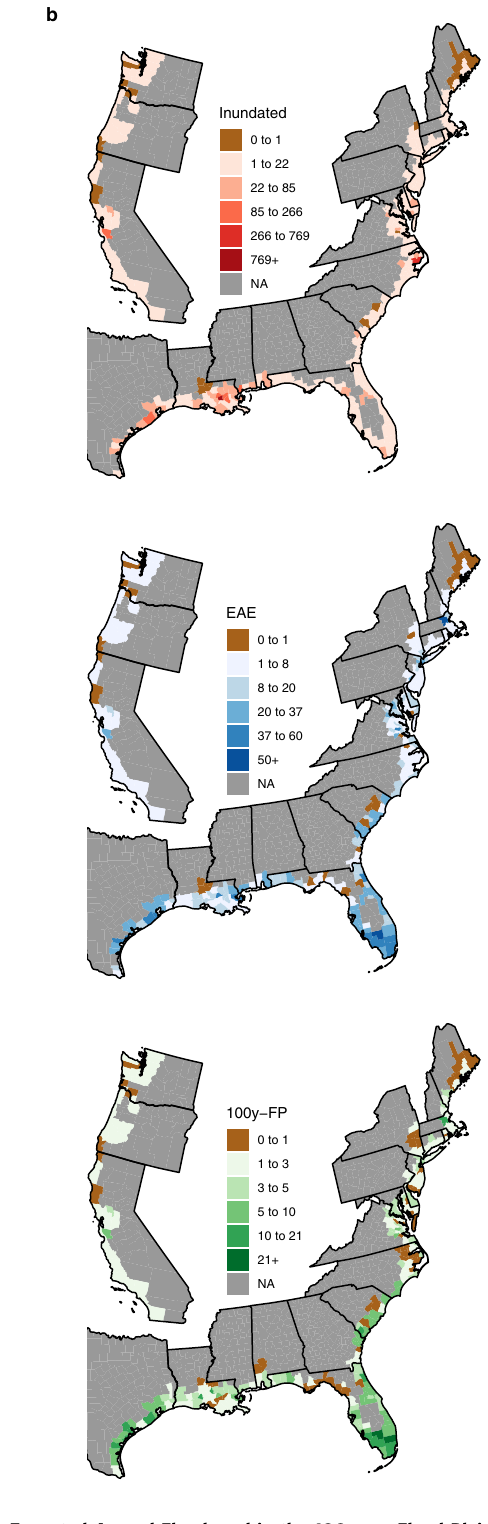
Fig. 2 Projected populations Inundated under the Mean Higher High Water, Expected Annual Flood, and in the 100-year Flood Plain under Shared Socioeconomic Pathway 2 (SSP) and Representative Concentration Pathway 4.5 (RCP). a shows the numeric distribution in 2100 and ( b ) shows the relative change in exposure between 2000 and 2100. Brown counties in ( b ) indicates declining